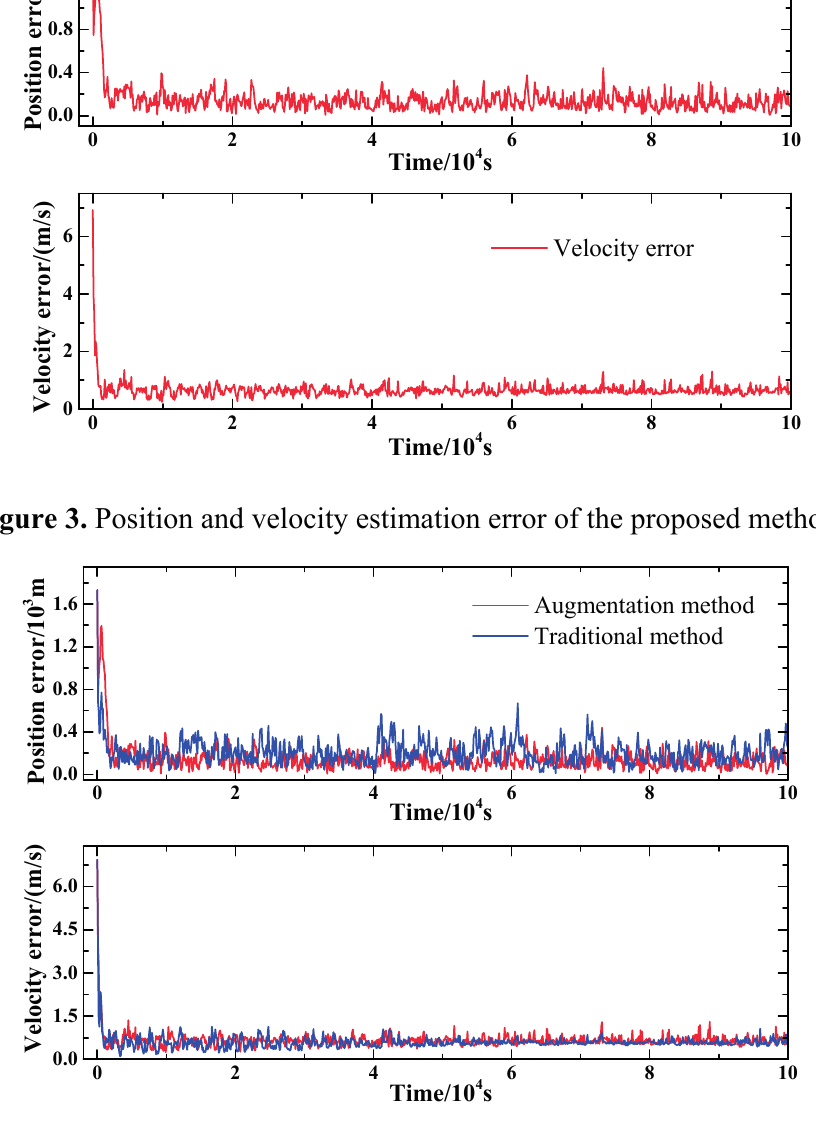
Figure 4. Comparison of the proposed method with the traditional